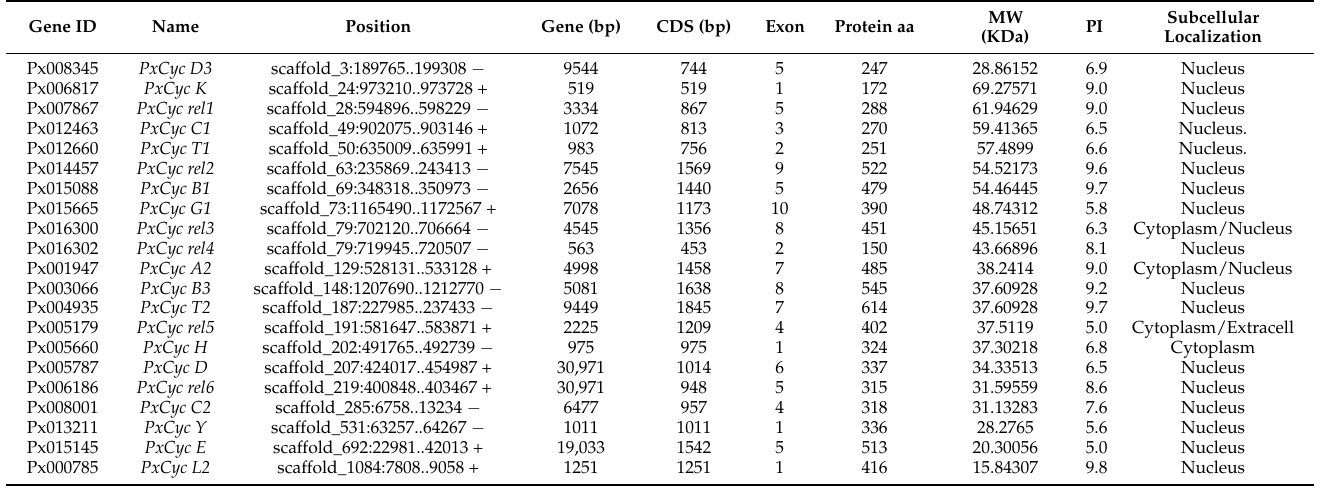
Table 1. Cyclin-like protein members in P. xylostella and their physicochemical